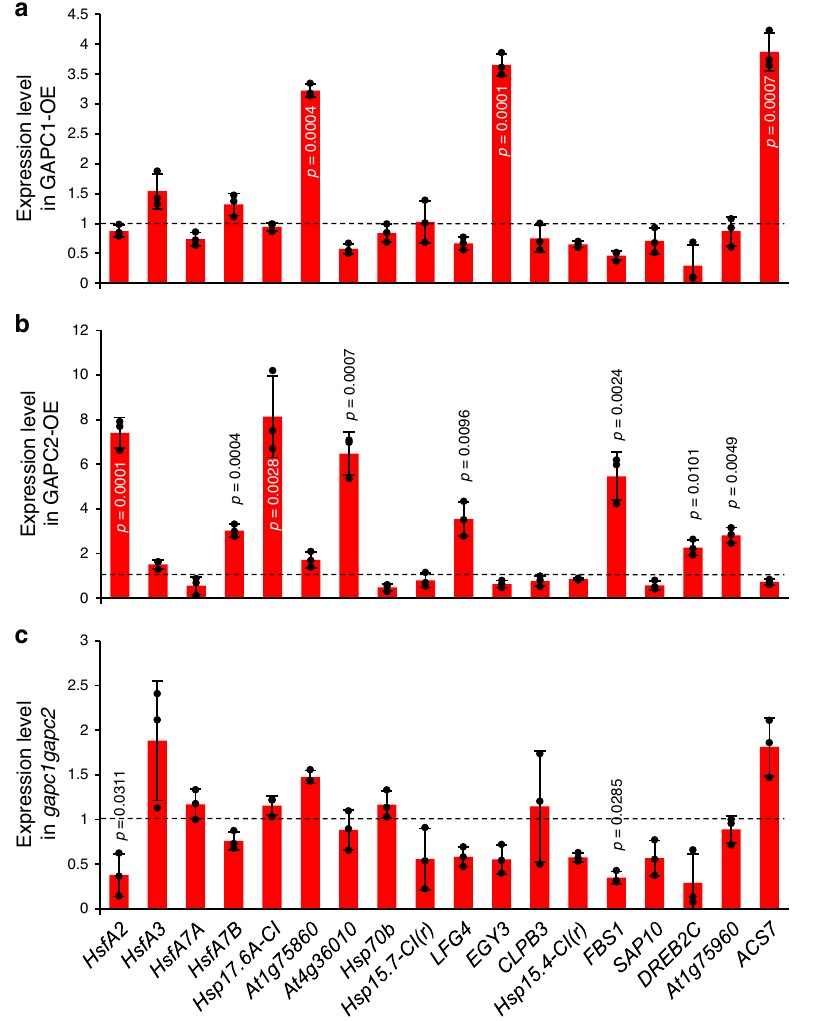
Fig. 4 Expression of heat-inducible genes in GAPC -altered Arabidopsis. Total RNA was extracted from 5-day-old seedlings of GAPC1 -OE ( a ), GAPC2 -OE ( b ), and gapc1gapc2 ( c ) treated at 37 °C for 5 h and quantitative RT-PCR was performed with gene-speci fi c primers. Values are average ± S.D. and shown as fold change to WT (dashed line). P values indicate signi fi cant difference from WT determined by two-tailed student ’ s t test ( n = 3 independent groups of >10 seedlings). Black dots represent individual data points. Hsf, heat shock transcription factor; Hsp, heat shock protein; At1g75860, DNA ligase; At4g36010, pathogenesis-related thaumatin superfamily protein; LFG4, LIFEGUARD4 (Bax inhibitor-1 family protein); EGY3, ETHYLENE-DEPENDENT GRAVITROPISM-DEFICIENT AND YELLOW-GREEN-LIKE3; CLPB3, CASEIN LYTIC PROTEINASE B3; FBS1, F-BOX STRESS INDUCED1; SAP10, STRESS- ASSOCIATED PROTEIN10; DREB2C, DEHYDRATION-RESPONSIVE ELEMENT BINDING PROTEIN 2C; At1g75960, AMP-dependent synthetase and ligase family protein; ACS7, 1-AMINO-CYCLOPROPANE-1-CARBOXYLATE